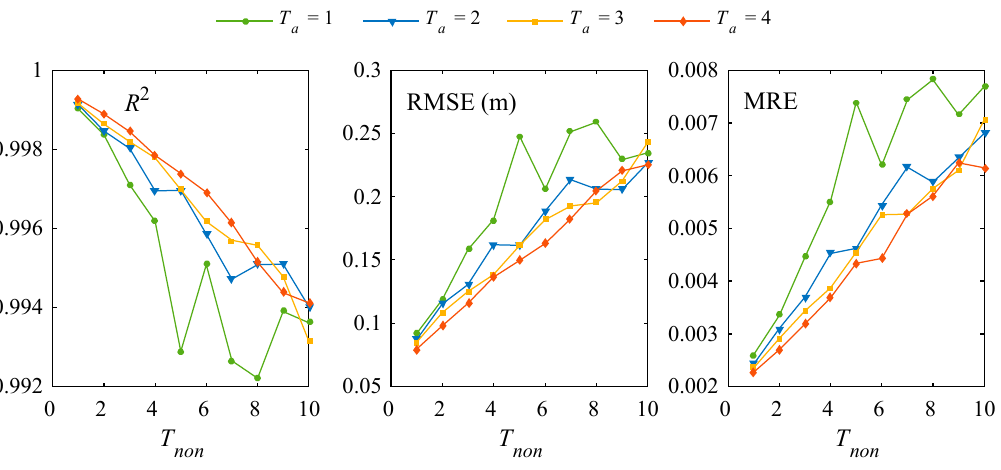
Figure 13. SVR+UKF performance under different assimilation/non-assimilation cycles at Chenglingji.